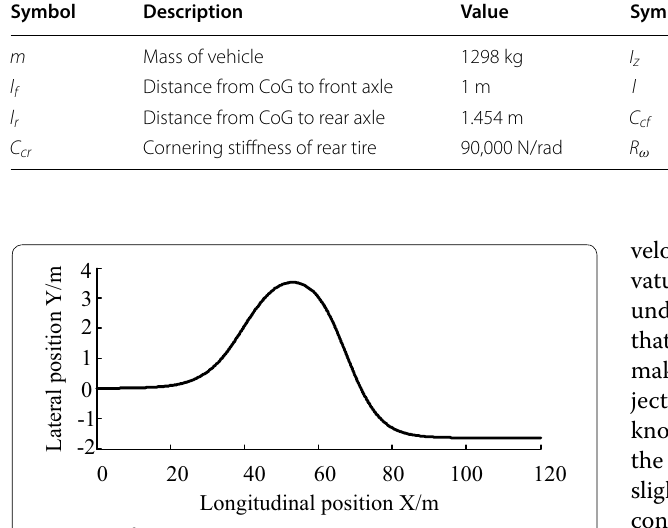
Figure 4 Reference